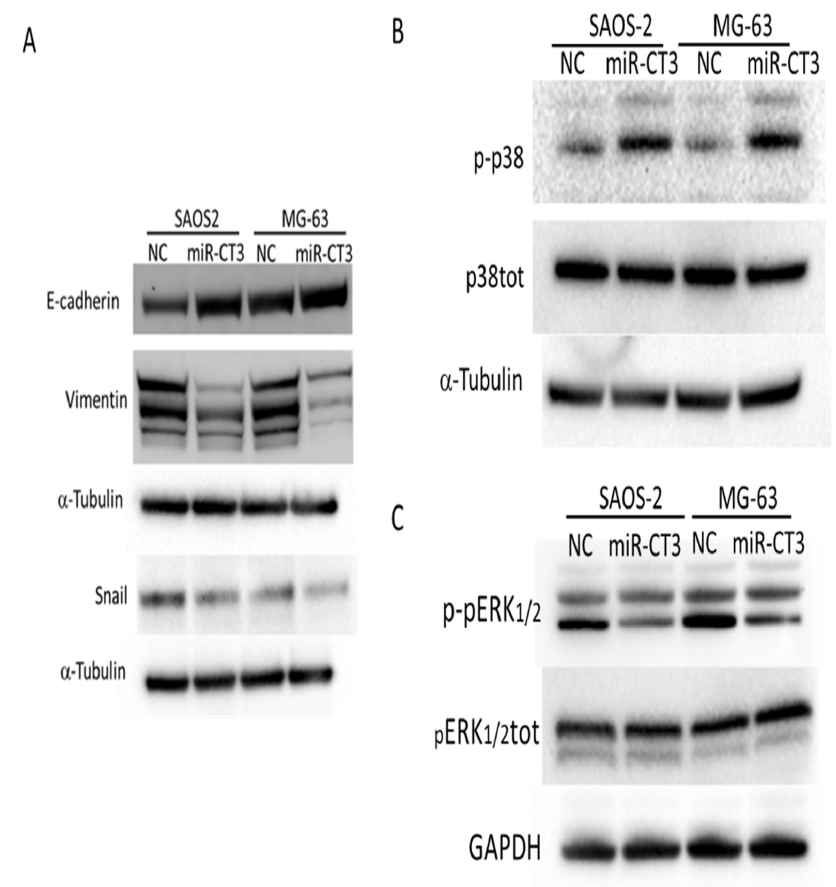
Figure 6. MiR-CT3 over-expression regulates the expression of proteins of the EMT-pathway . ( A ) Western blotting analysis of E-cadherin, Vimentin, Snail in SAOS-2 and MG-63 cells transfected with miR-CT3 mimics and NC for 24 h. Tubulin was used as loading control. ( B ) Western blotting analysis of phospho- and total-p38 MAPK in SAOS-2 and MG-63 cells transfected with miR-CT3 mimics and NC for 24 h. Tubulin was used as loading control. ( C ) Western blotting analysis of phospho- and total-p42/44 ERK in SAOS-2 and MG-63 cells transfected with miR-CT3 mimics and NC for 24 h. GAPDH was used as loading control.